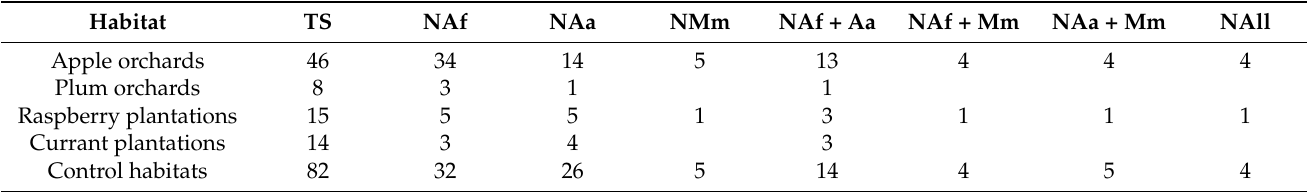
Table 3. Syntopy of granivorous rodents in commercial orchards, berry plantations, and control habitats. 2018–2020. Abbreviations: TS, number of trapping sessions; NAf, number of habitats inhabited by A. flavicollis ; NAa, by A. agrarius ; NMm, by M. minutus ; NAf + Aa, AAf + Mm, and NAa + Mm, by two species living syntopically; and NAll, by all three species living